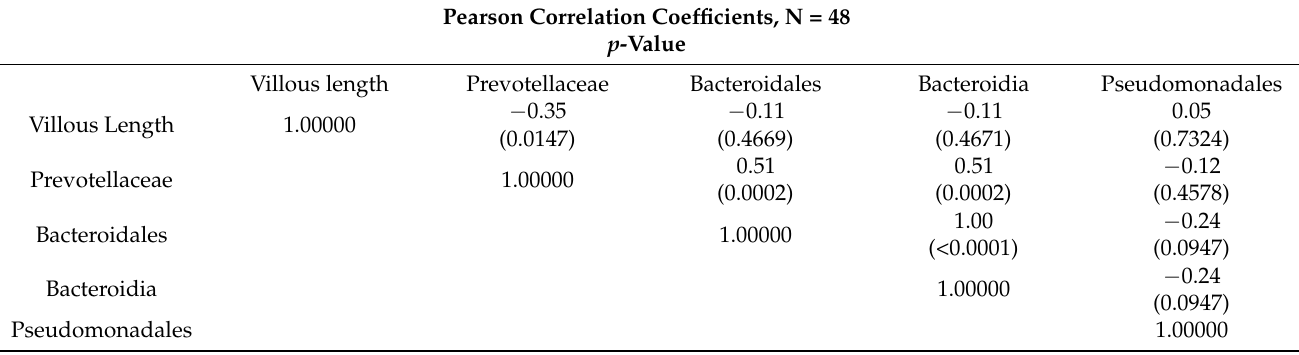
Figure 4. Linear Discriminant Analysis Effect Size (LEfSe) analysis results comparing duodenal and terminal ileum biopsies. The cladogram compares significant differences between species in the duodena of controls (red) and the TI controls (green). Species nodes in yellow are those that are not significantly different. The innermost nodes begin at the phylum level of classification and move outward to class, order, family and genus toward the exterior. Table 5. Pearson correlation analysis of duodenal villous length and bacterial OTU abundance. Correla- tion coefficient reported between each OTU and villous length, with p value reported in